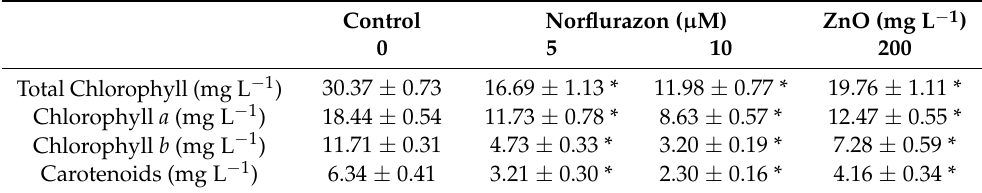
Table 1. Total chlorophyll, chlorophyll a , chlorophyll b , and carotenoids of CC-2344. All data are means ± SD of three biological replicates. Significant differences between the control and each condition are indicated by asterisks (*) ( p < 0.05).